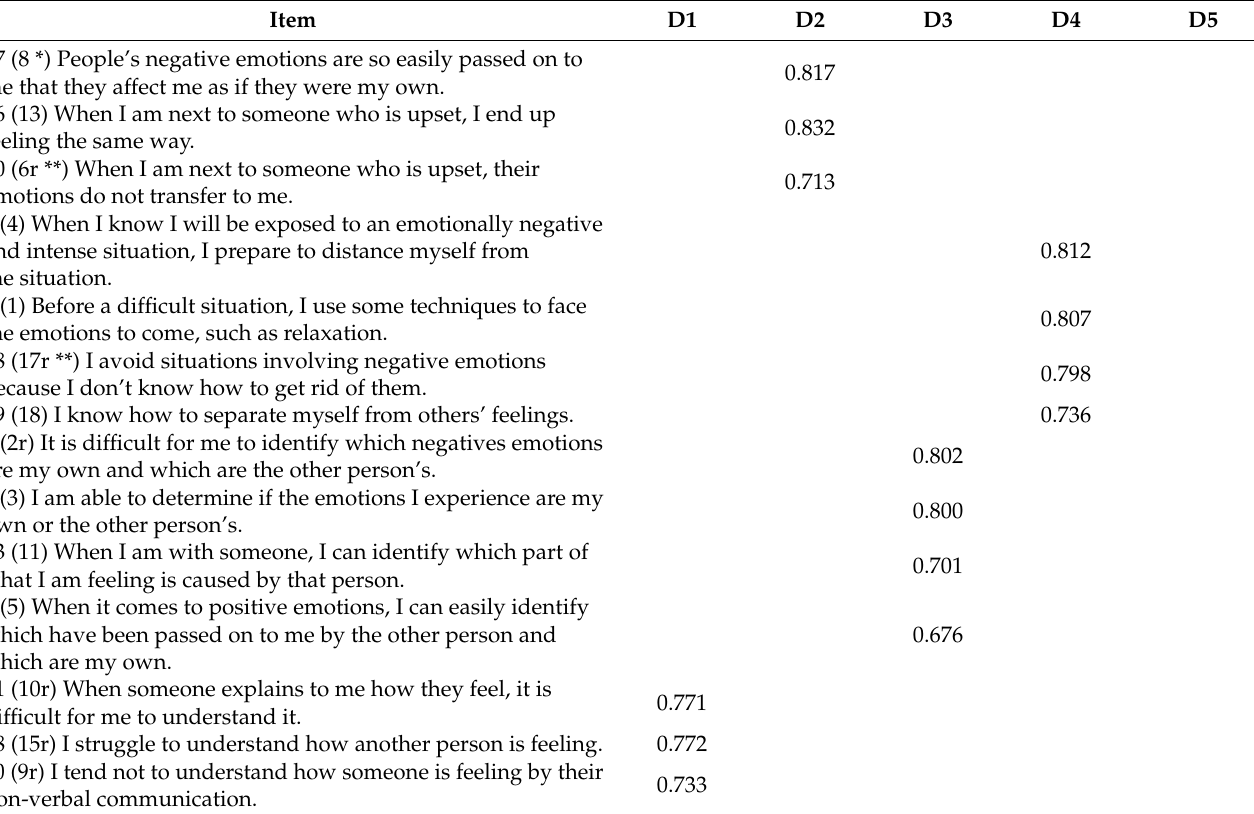
Table 1. EFA of the five Empathy Management Scale (EMS) factors. Item loadings for each dimension are shown. Item D1